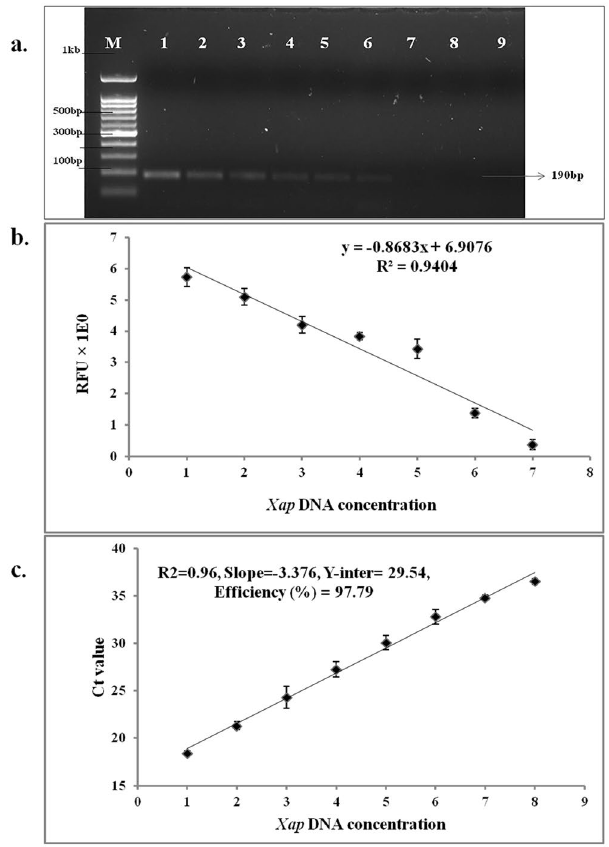
Polymerase Chain Reaction coupled with Capillary Electrophoresis. ( c ) qPCR: Real-time quantitative PCR, dpi: days post inoculation. (M-100 bp DNA ladder, 1–9 PCR reactions with 10 – fold serially diluted template DNA concentrations isolated from Xap cultures at 1–100 ng, 2–10 ng, 3–1 ng, 4–100 pg, 5–10 pg, 6-1 pg, 7–100 fg, 8–10 fg and 9-1